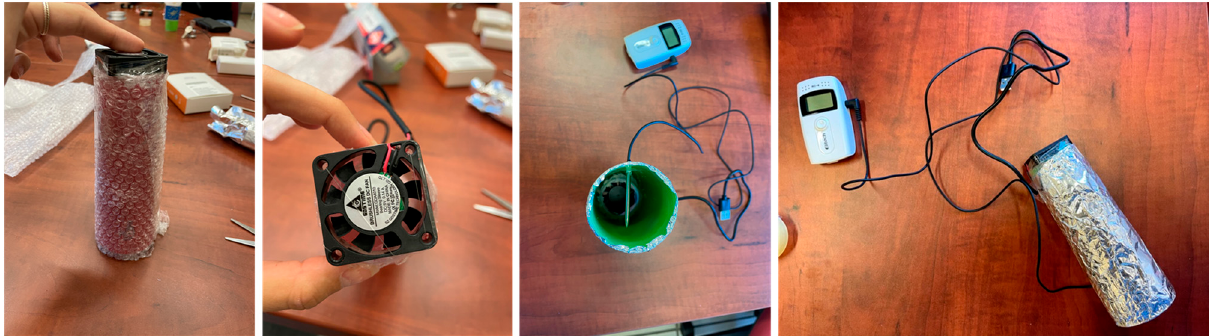
Figure 9. Mobile air temperature